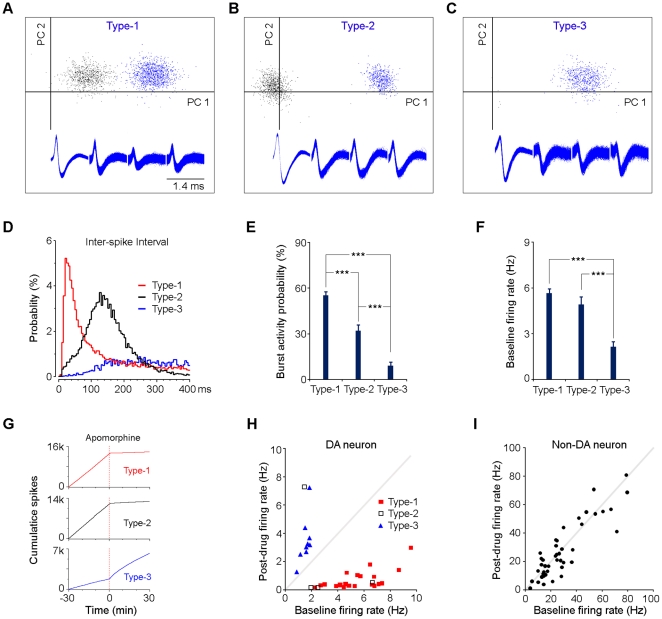
Firing patterns and pharmacology characterizations.(A–C) Three examples of tetrode-recorded putative dopamine neurons (type-1, type-2, and type-3) and their representative spike waveforms. PC1 and PC2 represent the first and second principal components in the principal component analysis, respectively. Blue dots represent individual spikes for the isolated dopamine neurons; black dots indicate individual spikes for other unsorted VTA neurons. (D) Inter-spike intervals of three examples of putative dopamine neurons (type-1, type-2, and type-3). (E) Percentages of burst firing for the three types of putative dopamine neurons. Error bars, s.e.m.; ***P<0.001, Student's t-test. (F) Baseline firing rates of the three types of putative dopamine neurons. Error bars, s.e.m.; ***P<0.001, Student's t-test. (G) Cumulative spike activity of thee examples of putative dopamine neurons (type-1, type-2, and type-3) in response to the dopamine receptor agonist apomorphine. It was noted that the type-1 and type-3 putative dopamine neurons were recorded simultaneously from one tetrode. (H and I) Baseline and post-drug firing rates of putative dopamine (H) and non-dopamine (I) neurons. Mice were injected with the dopamine receptor agonist apomorphine (1 mg/kg, i.p.) and the firing rates were averaged 30 min before and 30 min after apomorphine injection.